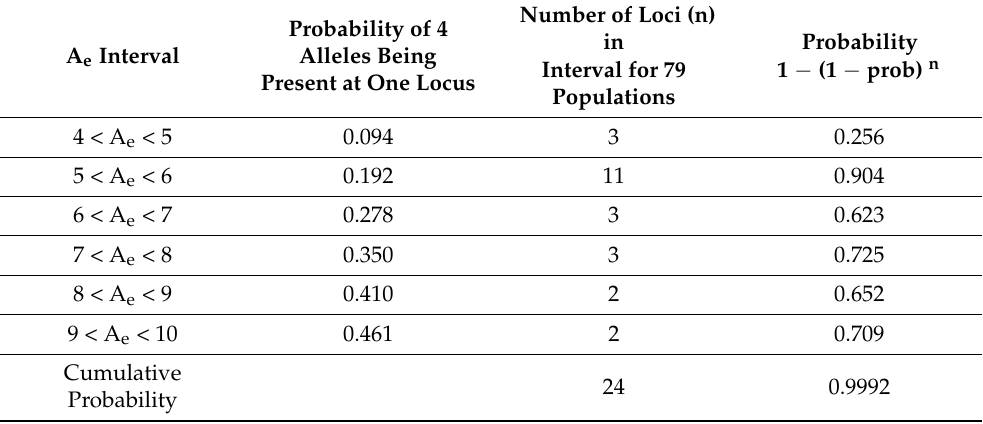
Table 1. Lower bound probabilities of seeing 4 alleles at one locus in a two-person mixture (from [13]). Probability of 4 A e Interval Alleles Being Present at One